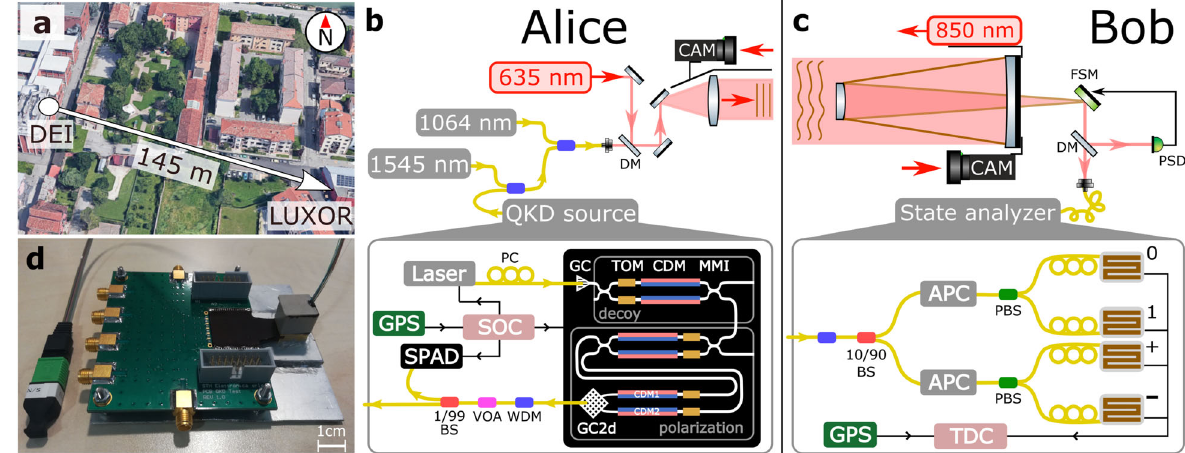
Fig. 1 Location of the fi eld trial and QCoSOne setup. a Location of the fi eld test in Padua. Map Data from Google [©2019 Google]. b Alice ’ s terminal with the sketch of the QKD source and chip schematic. DM dichroic mirror, CAM camera. c Bob ’ s terminal with the scheme of the state analyzer. d Picture of the packaged chip soldered to the external control board with the input/output fi ber